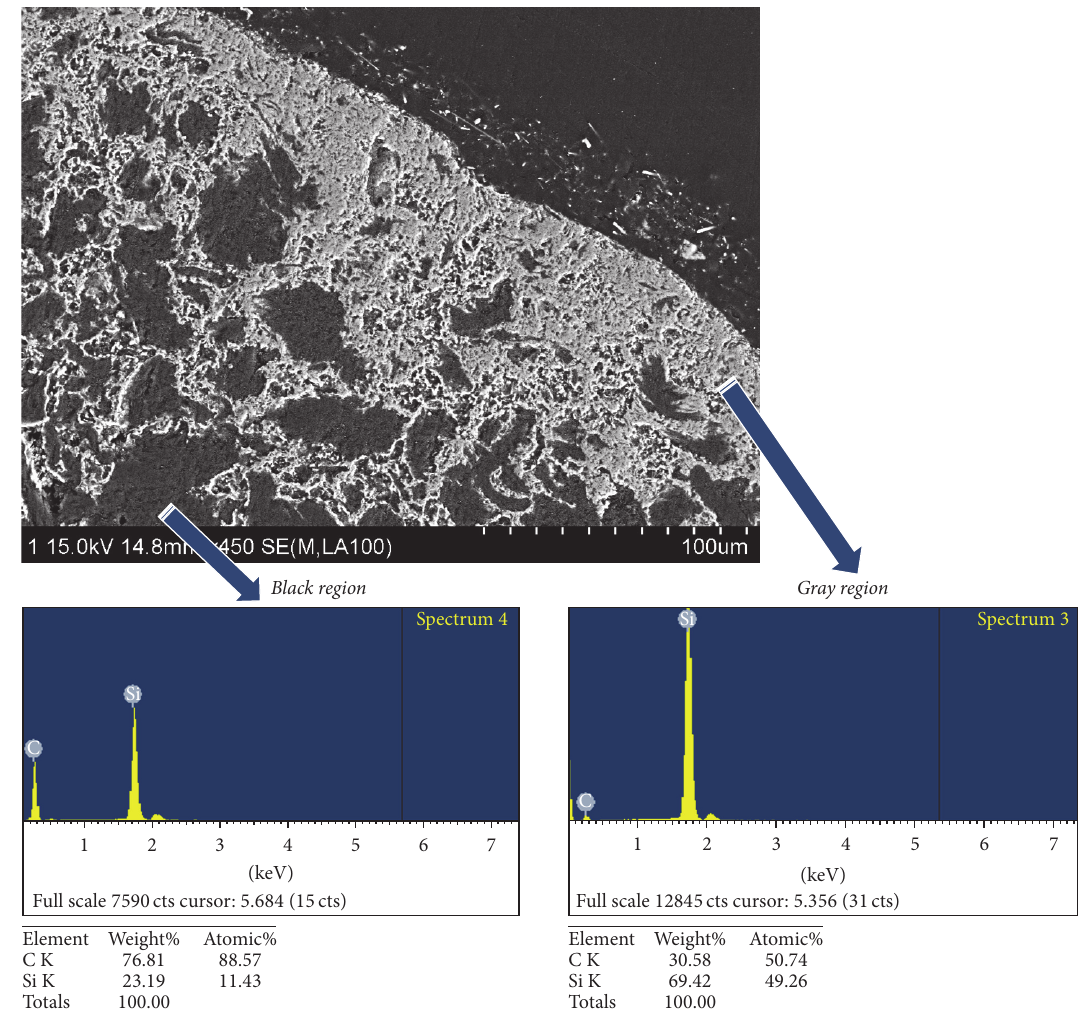
Figure 3: Backscattered images and EDS analysis of cross-sectional SiC conversion coating on graphite (reaction zone